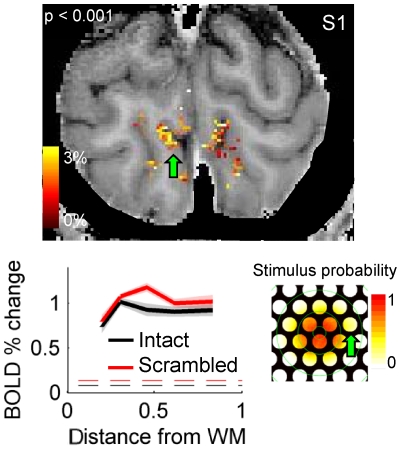
An example of a selected cluster of significantly modulated voxels.Voxels most strongly modulated by stimulus presentation (p<0.001) are shown overlaid on the T1-weighted anatomical reference, illustrating adherence of activation to GM. Map on lower right indicates probability that part of an intact or scrambled object occurred in each region of the visual field; image subtends ±7.6°. Green arrows indicate one region of interes and corresponding visual field location. Laminar profiles are shown with shading indicating standard error, 7 scans.